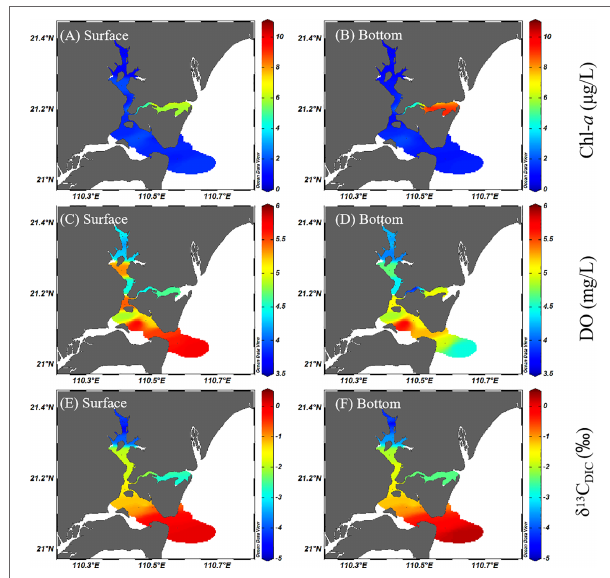
FIGURE 3 | Spatial distributions of Chl-a (A, B) , DO (C, D) , and stable isotope of DIC (E, F) in surface and bottom water of Zhanjiang Bay during the sampling period. Chl-a, chlorophyll a; DO, dissolved oxygen; DIC, dissolved inorganic